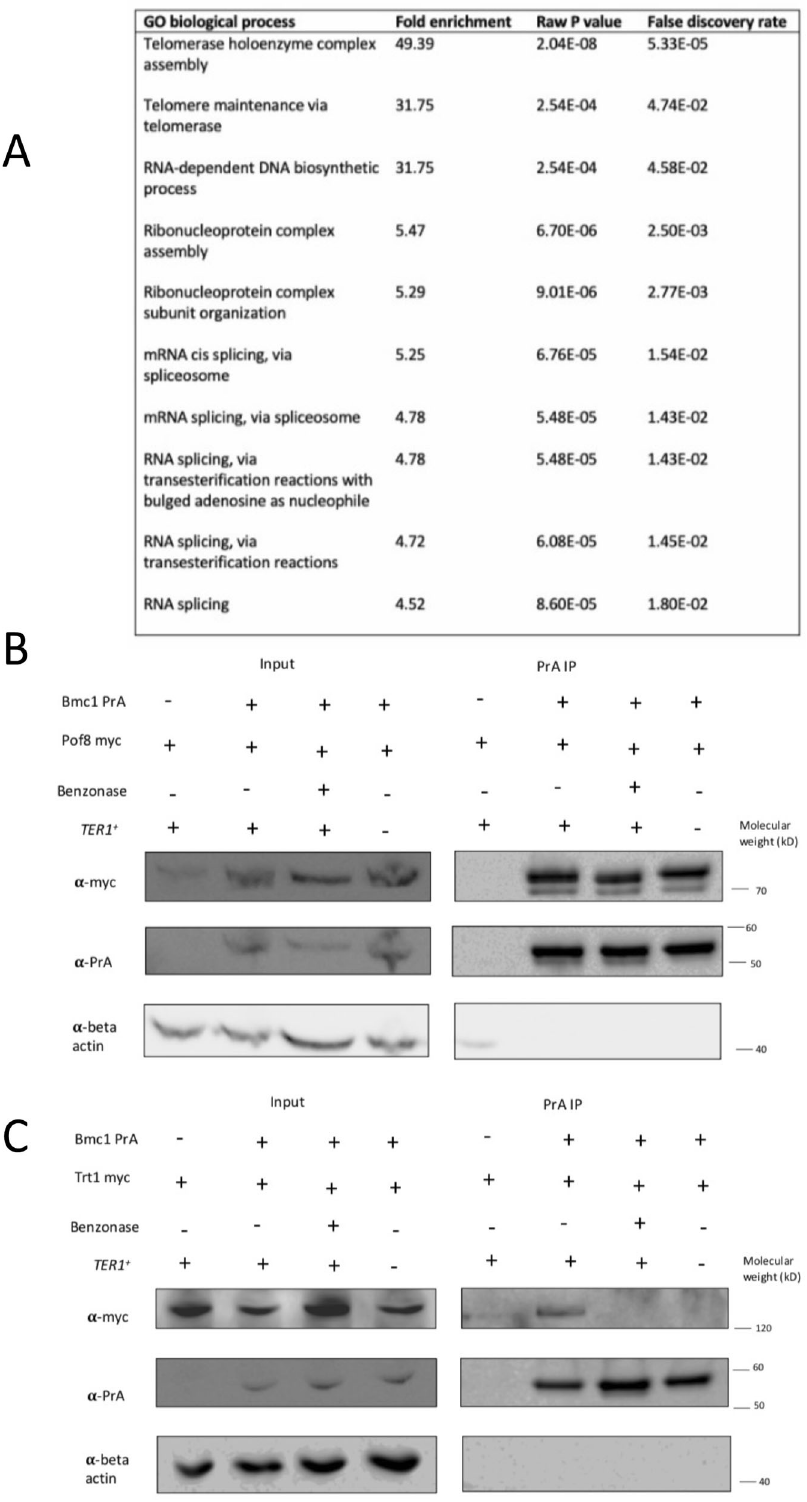
Fig. 3 Bmc1 interacts with components of the mature telomerase holoenzyme. A Gene ontology analysis (biological process) of top 50 Bmc1 protein interactors. B , C Examination and nucleic acid-dependence of interactions between Bmc1 and Pof8 ( B ) and Bmc1 and Trt1 ( C ) by co-immunoprecipitation and western blotting. Blots were reprobed for beta-actin as a loading control. Source data are provided as a Source Data fi